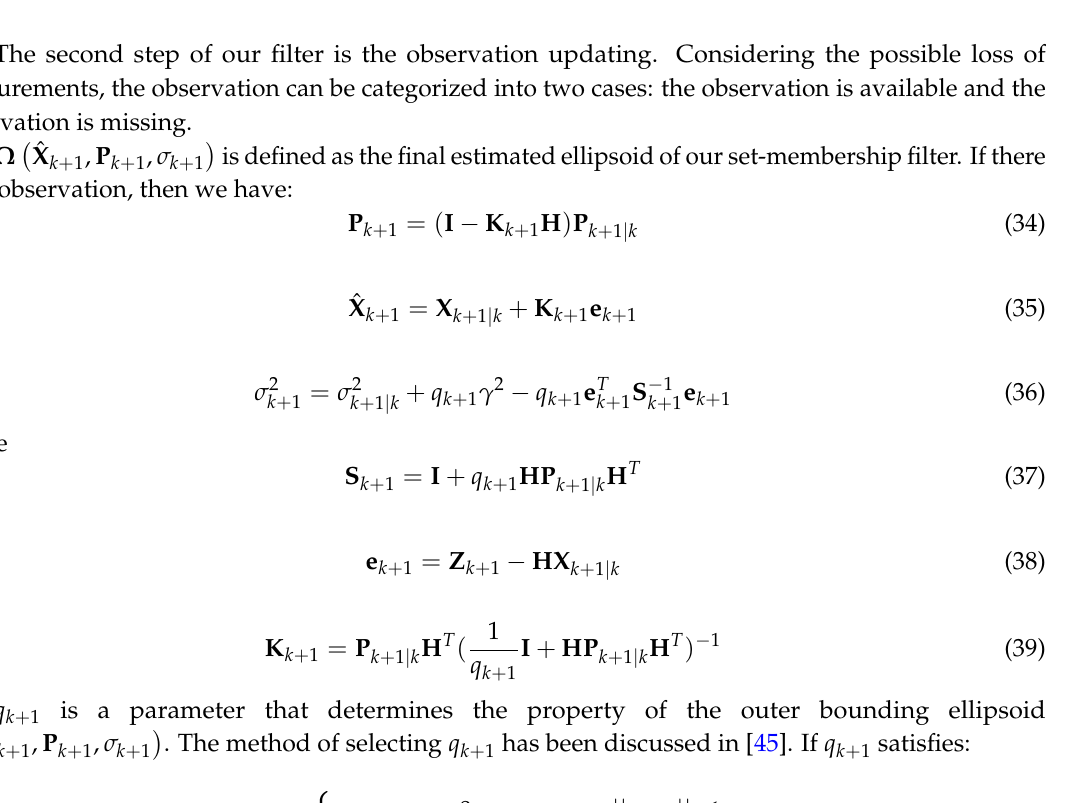
Figure 11. The process of time updating and observation updating without observation missing. ( a ) The process of time updating; ( b ) Observation updating without observation